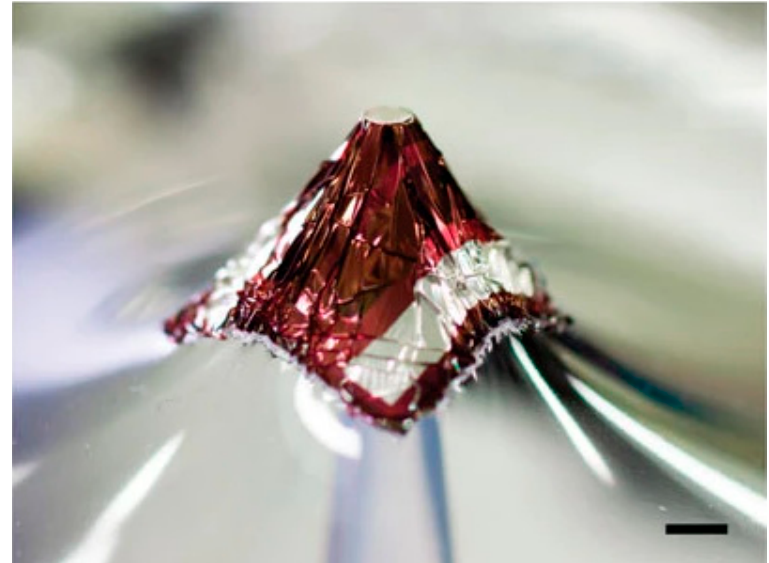
Figure 6. The thin polymer PET foil based solar cell attatched to an elastomeric support developed by Kaltenbrunner et al. This image shows the three-diamentional deformablity of the structure when deformed by applying pressure from a 1.5 mm diameter tube. Taken from [112]; this image is licensed